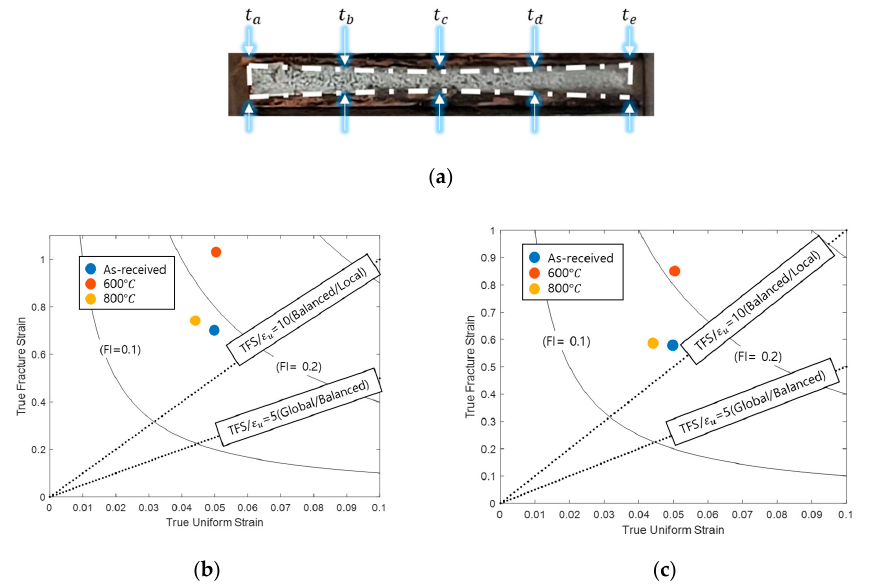
Figure 10. Local formability: ( a ) Cross section of a fracture specimen after the tensile test; ( b ) 𝑇𝐹𝑆 (cid:3028)(cid:3045)(cid:3032)(cid:3028) ; ( c ) 𝑇𝐹𝑆 (cid:3047)(cid:3035)(cid:3036)(cid:3030)(cid:3038)(cid:3041)(cid:3032)(cid:3046)(cid:3046) . ( c ) TFS thickness